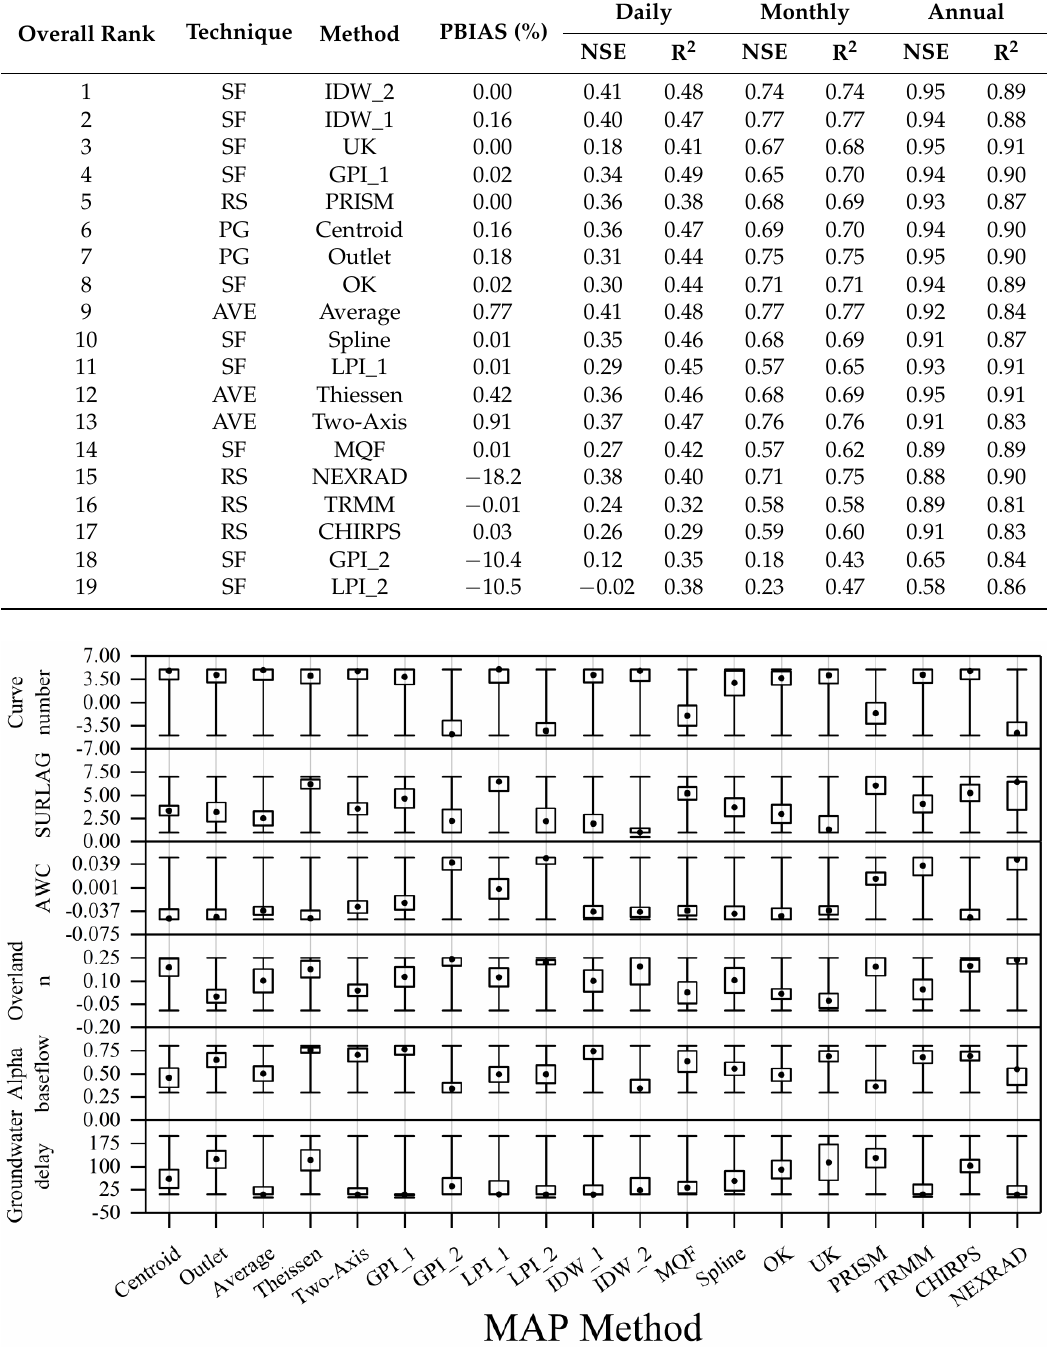
Figure 3. SWAT-cup derived best-fit calibration parameters (black dots) and parameter ranges (black whiskers) for each SWAT calibration parameter ( n = 6) presented as a function of 19 different mean areal precipitation methods. Whisker’s plots show user-specified physically meaningful bounds for each calibration parameter, and boxes show the post-calibration parameter ranges for the Hinkson Creek Watershed, Missouri, USA.